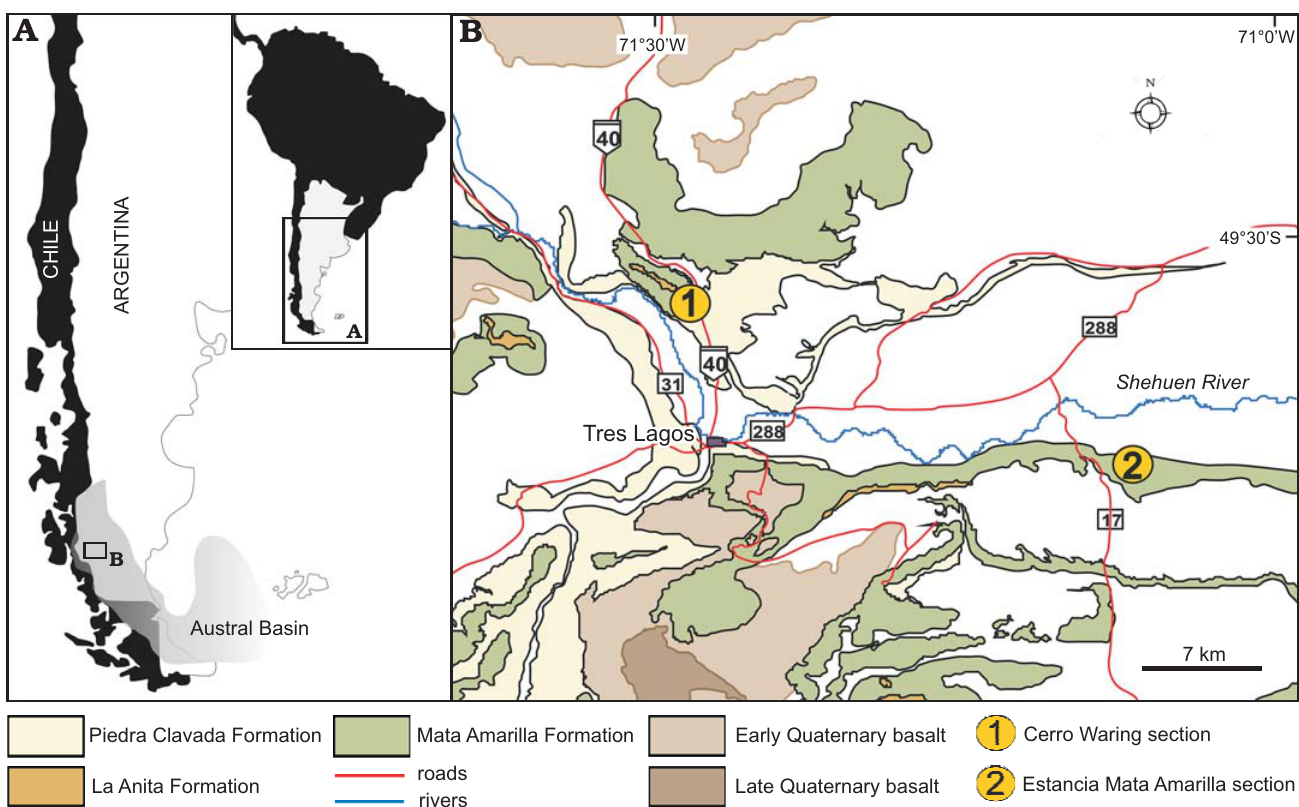
Fig. 1. Geographic ( A ) and geological ( B ) maps of the studied area (Tres Lagos Town, Santa Cruz Province, Argentina), showing the location of the studied sections (modified from Varela